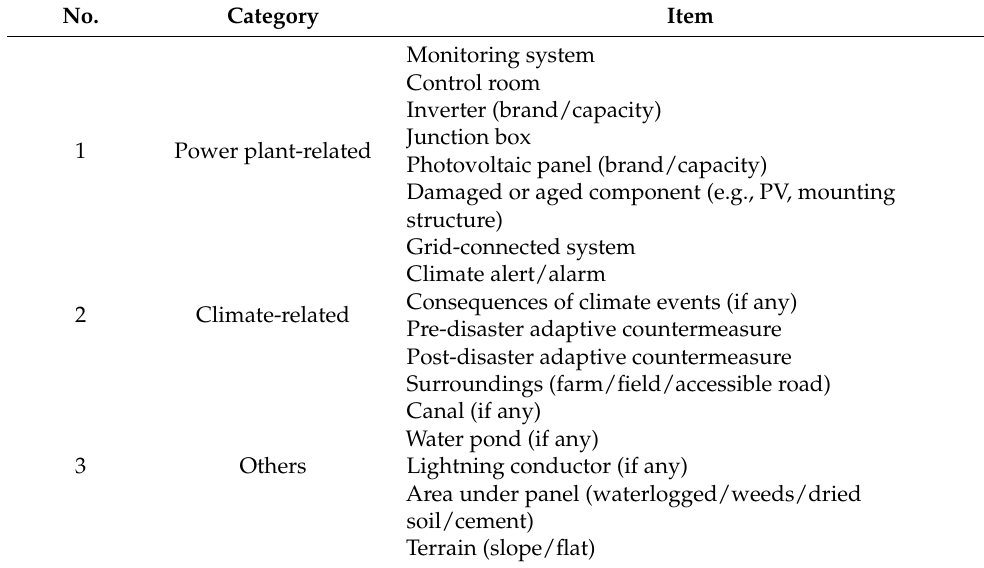
Table 2. Observed items from solar power plant self-administered observations.